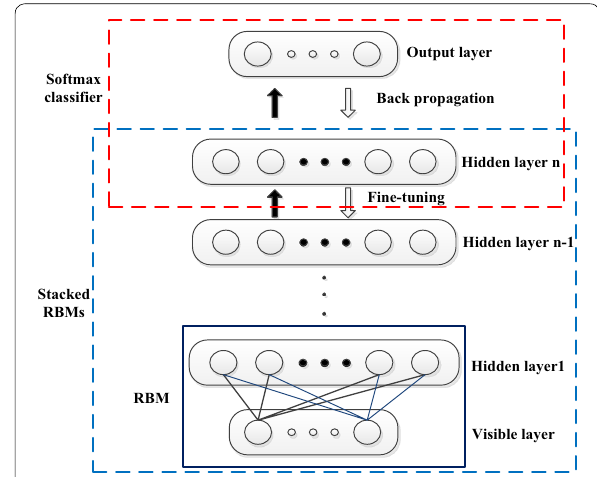
Figure 6 Architecture and training process of deep belief